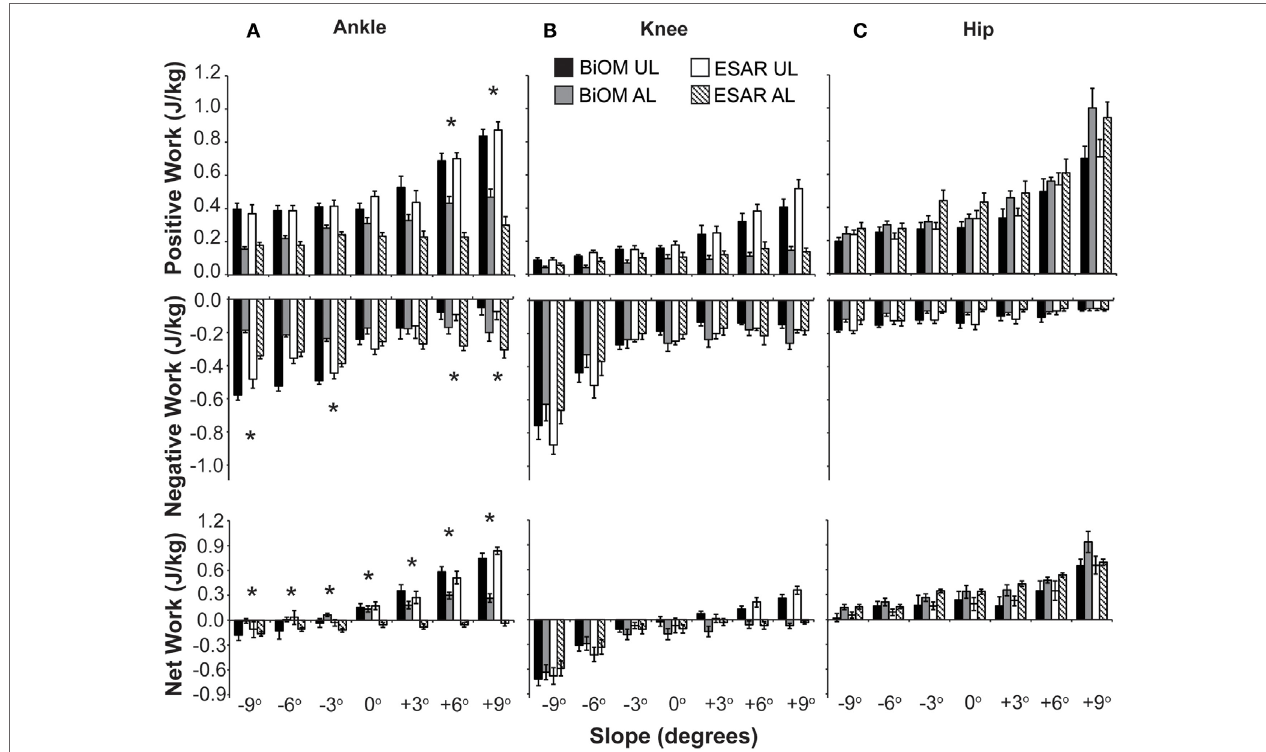
FigUre 4 | (a) Ankle, (B) knee, and (c) hip positive (top), negative (middle), and net (bottom) work over an entire stride for subjects using the BiOM powered prosthesis [unaffected leg (UL) is black, affected leg (AL) is gray], and passive-elastic energy storage and return (ESAR) prosthesis (UL is white and AL is hashed) during walking at 1.25 m/s across a range of slopes. * indicates a significant difference in AL work between use of the BiOM powered and passive-elastic ESAR